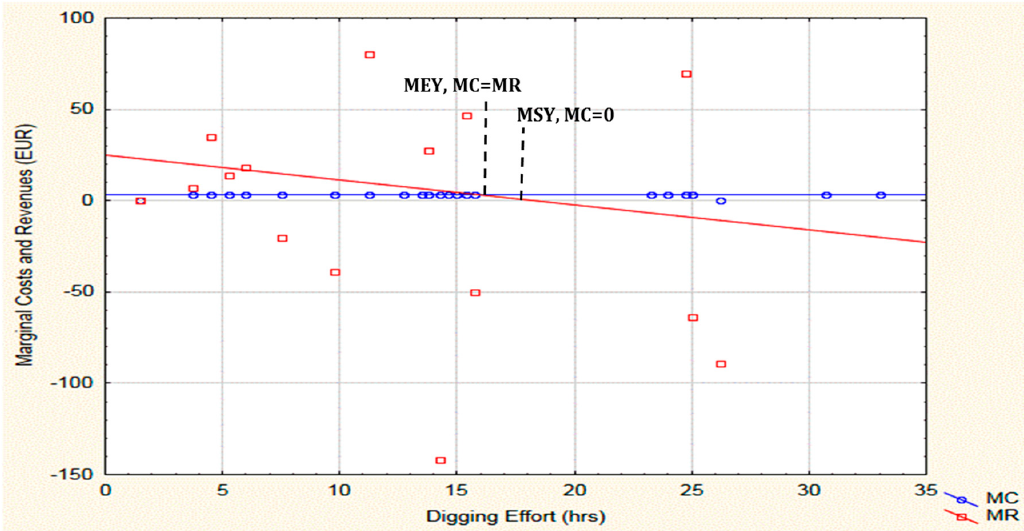
Figure 7. Marginal revenues and costs against digging effort in Aveiro lagoon for the surveying period 2012–2013. Note: MEY = Maximum Economic Yield; MSY = Maximum Sustainable Yield; MC = Marginal Costs; MR = Marginal Revenues.